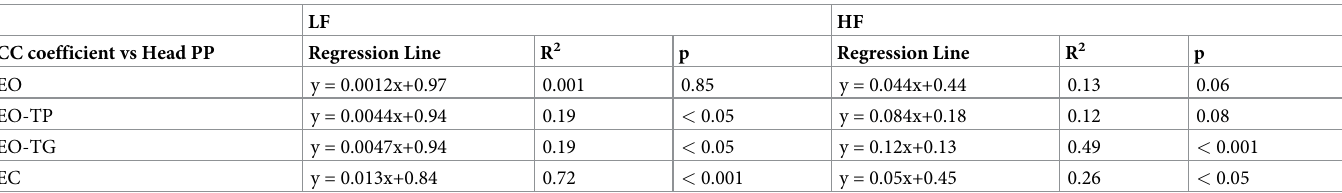
Table 2. CC coefficient vs Head